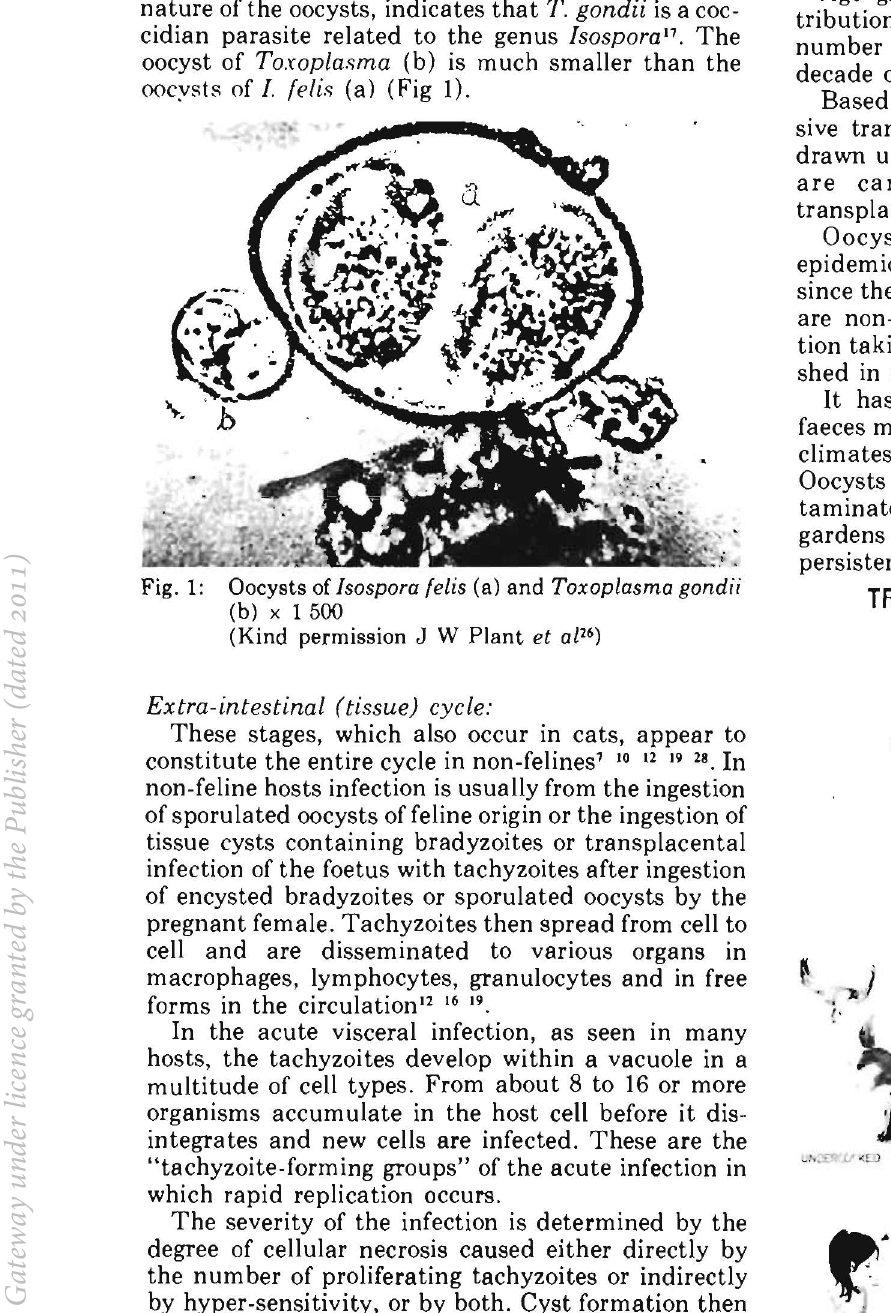
Fig. 2: Life cycle of Toxoplasma gondii (Adapted from FrenkePl) Toxoplasma oocysts are found to be resistant to most common detergents, acids and alkalis, but